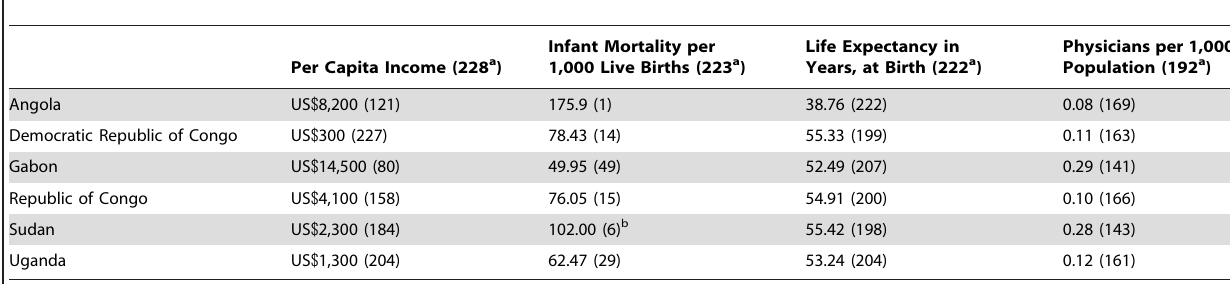
Table 2. Select economic and health indicators for countries with previous large outbreaks of Ebola or Marburg hemorrhagic fever (total number of countries which rank is based